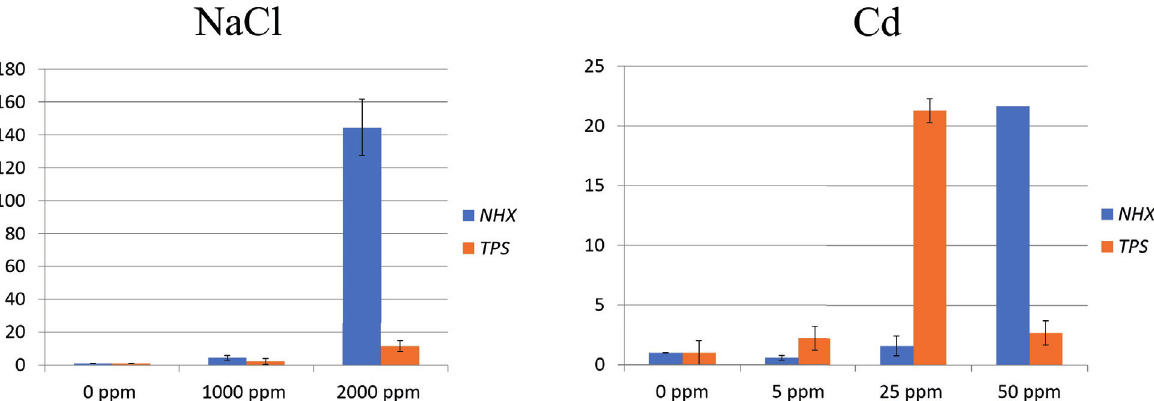
Figure 6. Effect of NaCl and Cd on TPS and NHX expression in V. turcica leaves. Data normalized to 18S rRNA are expressed as mean relative Ct(Cp) values of three independent experiments. Gene expression was quantifi ed by qRT-PCR in V. turcica leaves treated for 1 month with NaCl (1000 and 2000 ppm) and Cd (5, 25, and 50 ppm). Untreated leaves were taken as